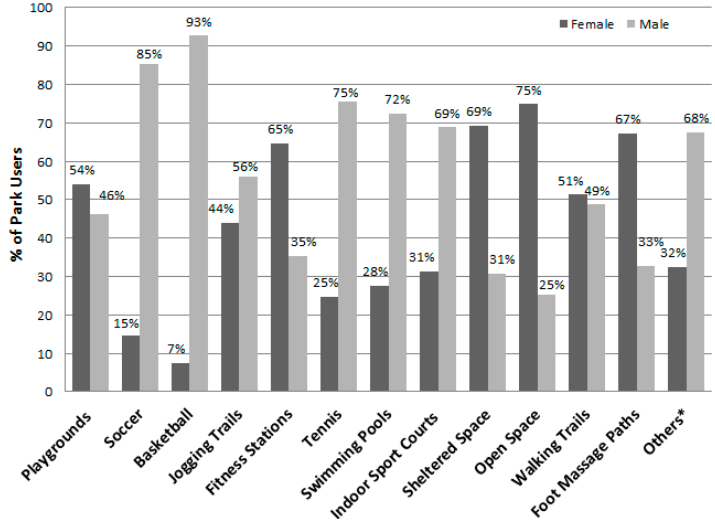
Figure 9. Percent of park area users by gender (total n : female = 11,120, male = 17,465). * Others include archery range, climbing wall, gateball courts, lawn bowl greens, and roller-skating areas.